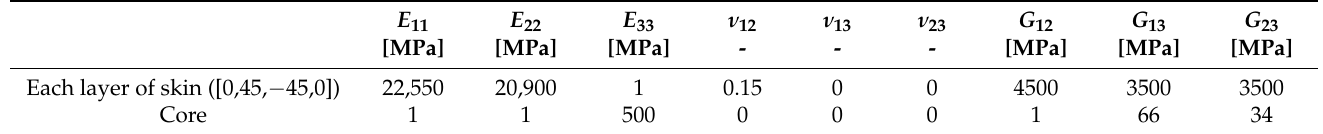
Table 2. Material parameters of the composite sandwich panel of the idealized spoiler demonstrator